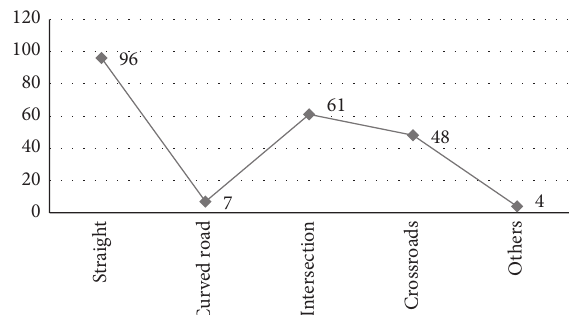
Figure 4: Distribution of road types in accidents.